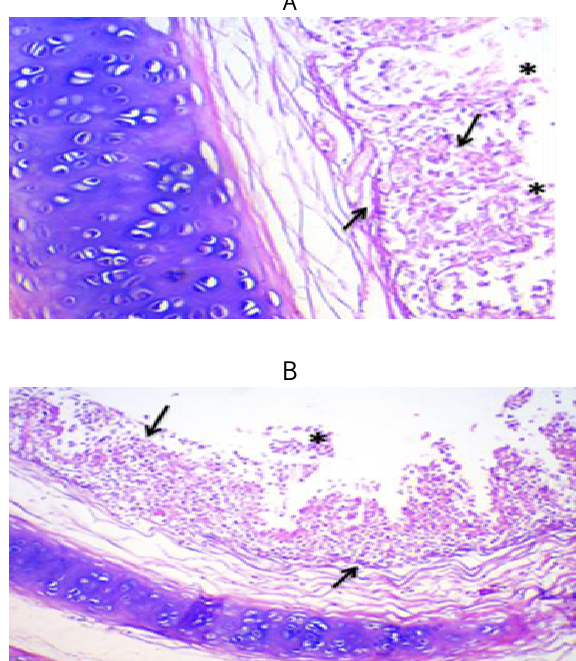
Figure,5: Trachea showed moderate to severe de- cilliation in the tracheal layer, also severe degeneration in the lamina properia (myofiber). The epithelium appeared hyperplastic and the lamina propria distended (black arrows A&B) with infiltration of macrophages and lymphocytes into the submucosa and lamina propria, the epithelial cells degenerated and desquamated in tracheal lumens(* A&B). No mucus glands were detected due to decilliation, and some infiltration by MNC (H&E